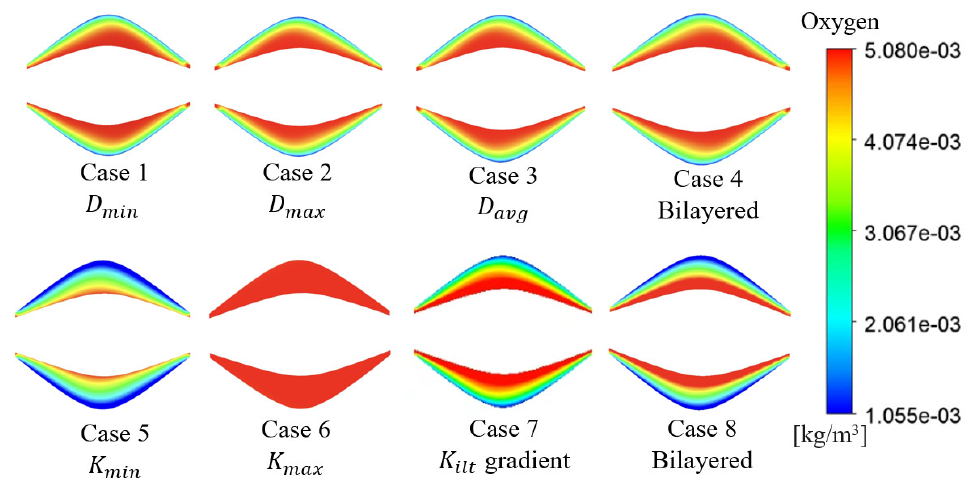
Figure 2. Contours of oxygen concentration in ILT for all analyzed cases (Table 2) on the same scale. Only the ILT region is plotted for each case. Top panel simulations represent cases where the diffusion coefficient is varied in one- and multilayer ILTs. Bottom panel simulations represent cases where permeability is varied in one- and multilayer ILTs.